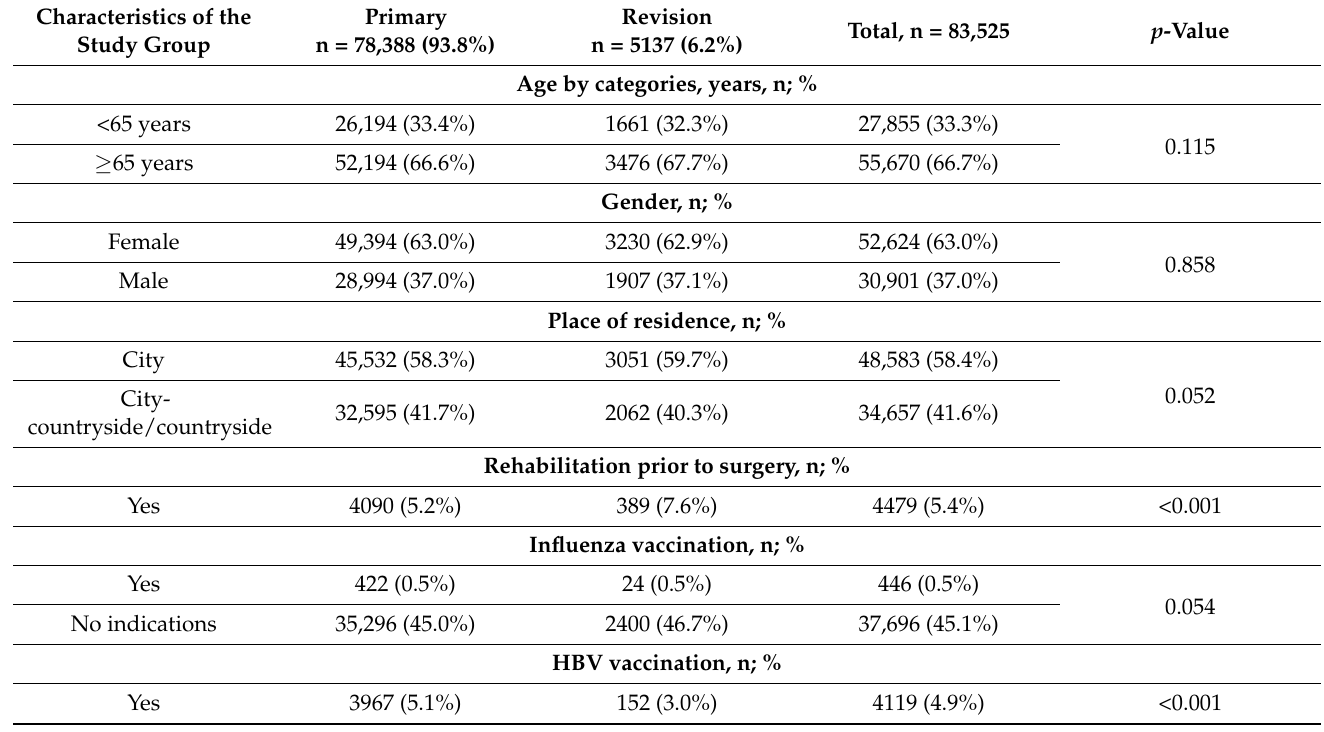
Table 3. Comparison of primary and revision